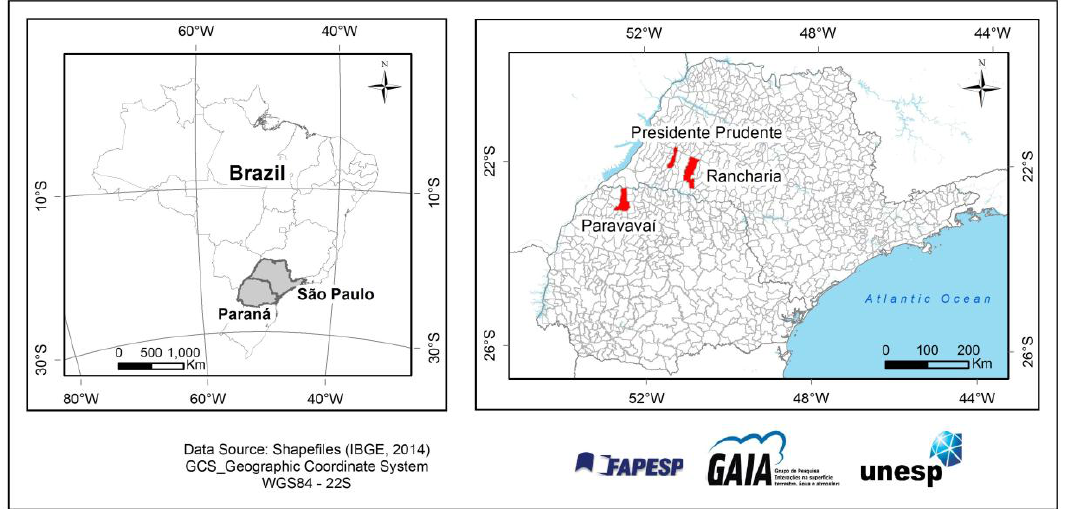
Figure 1. Location map of the study areas.